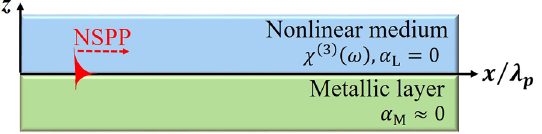
Figure 1: Nonlinear plasmonic waveguide configuration for exciting invariant PFC and constructing SPL. Our suggested scheme comprises a plasmonic scheme placed as the bottom layer and a nonlinear medium situated on top. This nonlinear waveguide should possess tunable nonlinearity and vanishing loss. 𝜒 (3) ( 𝜔 ) is the = 0 is its linear absorption nonlinear coefficient of the medium, 𝛼 L : = Im [ 𝜺 ( k ,𝜔 ) ] as suppressed loss of coefficient, and we assume 𝛼 M the plasmonic